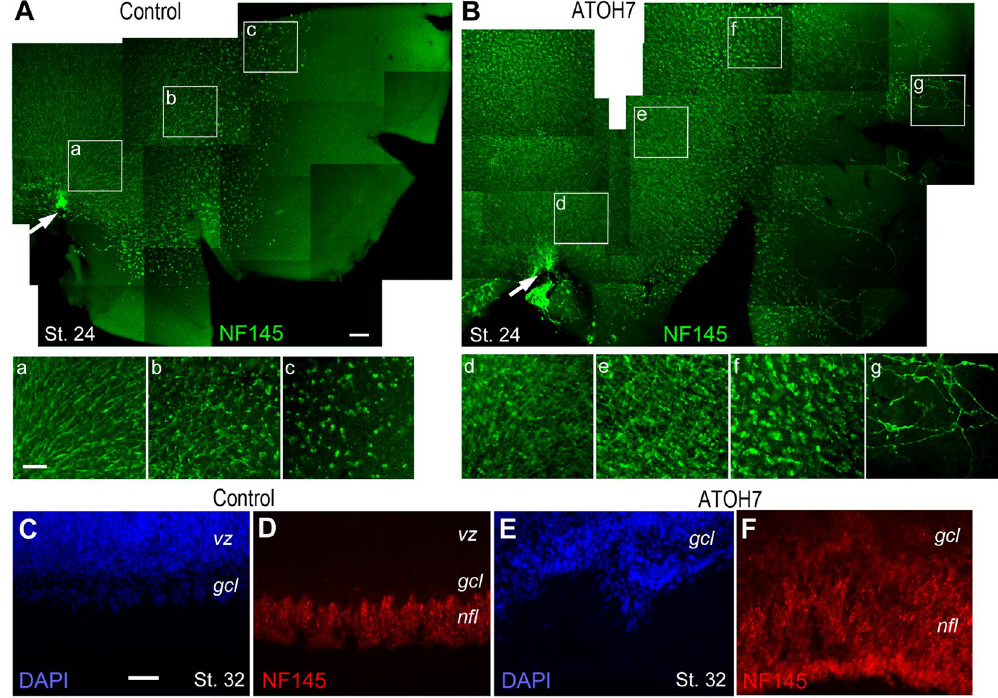
Figure 4. Axonal projection of human ATOH7-induced retinal ganglion cells. ( A , B ) Immunofluorescent images of flat mount retinas infected at stage 17 and labeled at stage 24 for NF145. The NF145-expressing retinal ganglion cells from different regions of control virus ( A ) and ATOH7 virus ( B ) infected retinas are shown at 2.5-fold magnification in (a–c) and (d–g), respectively. Arrows in ( A ) and ( B ) point to the optic nerve heads. Note the misprojected growth cones and axons of ATOH7-induced ectopic RGCs ( B , G ). ( C – F ) Immunocytochemistry of NF145 on cross sections demonstrates that retinas infected by ATOH7 virus ( E , F ) show increased thickness of the RGC fiber layer compared to the control virus infected retinas ( C , D ). gcl , ganglion cell layer; nfl , neurofiber layer; vz , ventricular zone. Scale bars: A (for A , B ), 100 μ m; a (for a–g), 50 μ m; C (for C – F ), 50 μ